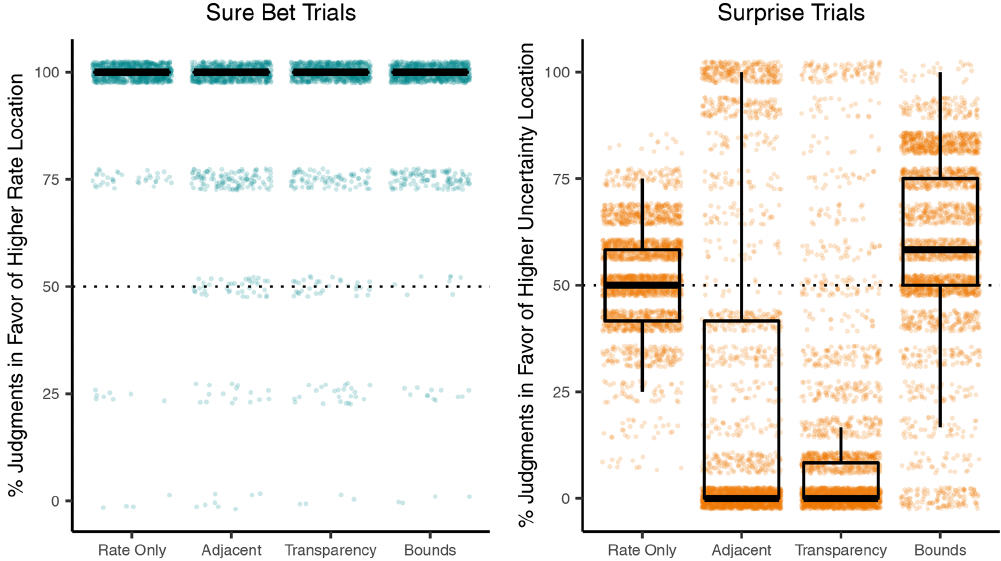
Figure 6. Percentage of trials where the location of a higher rate (sure bet trials, turquoise) or higher uncertainty (surprise trials, orange) was selected in the Comparative Judgment task. See example screenshots of sure bet and surprise trials in Figs. S4 and S3, respectively. Boxplots are over mean percentages across participants, by condition. Each dot represents the mean percentage of one participant, slightly jittered to increase visibility.